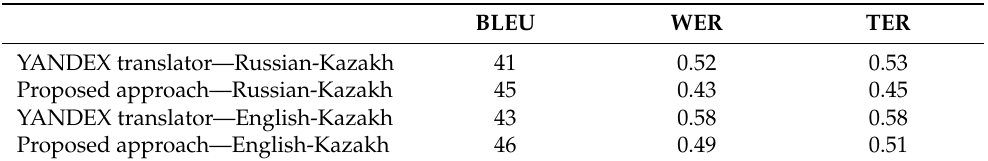
Table 4. Evaluations of post-editing of complex sentences in English-Kazakh and Russian-Kazakh translation. BLEU WER